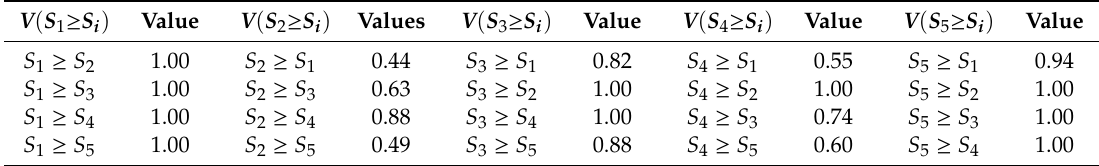
Table 5. Results of possibility degree S j = V ( S j ≥ S i ) .